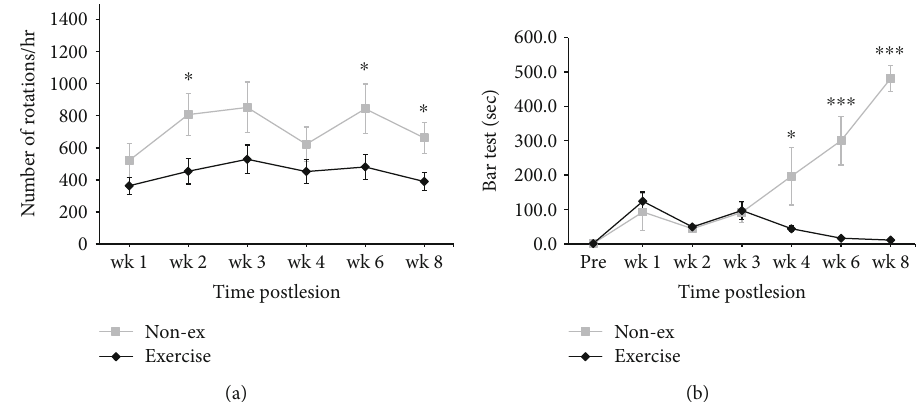
Figure 2: E ff ects of exercise on apomorphine-induced rotational behavior (a) and akinesia determined using the bar test (b) in the sham and exercise groups. Error bars =SEM, ∗ p < 0 : 05 , ∗∗∗ p < 0 : 001 , signi fi cant di ff erence between the two